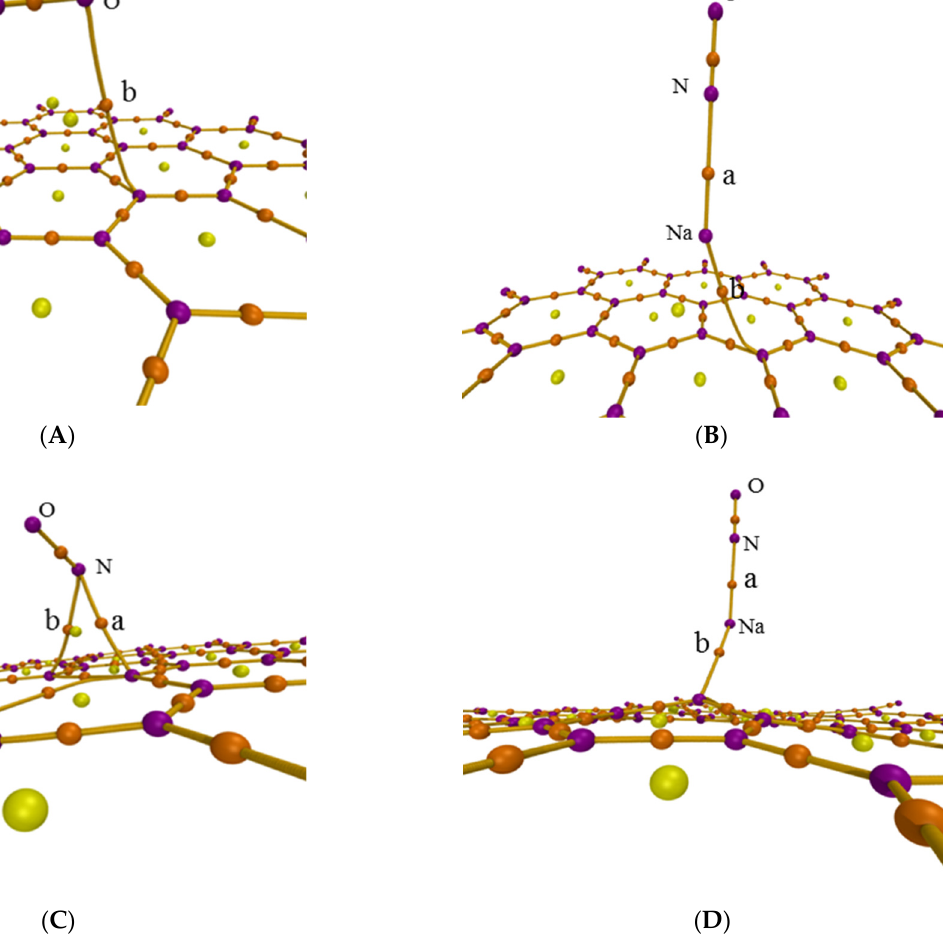
Figure 3. AIM topology map of the adsorption configurations for ( A ) graphene-NO, ( B ) graphene-Na-NO, and ( C ) gsv-NO, ( D ) gsv-Na-NO.